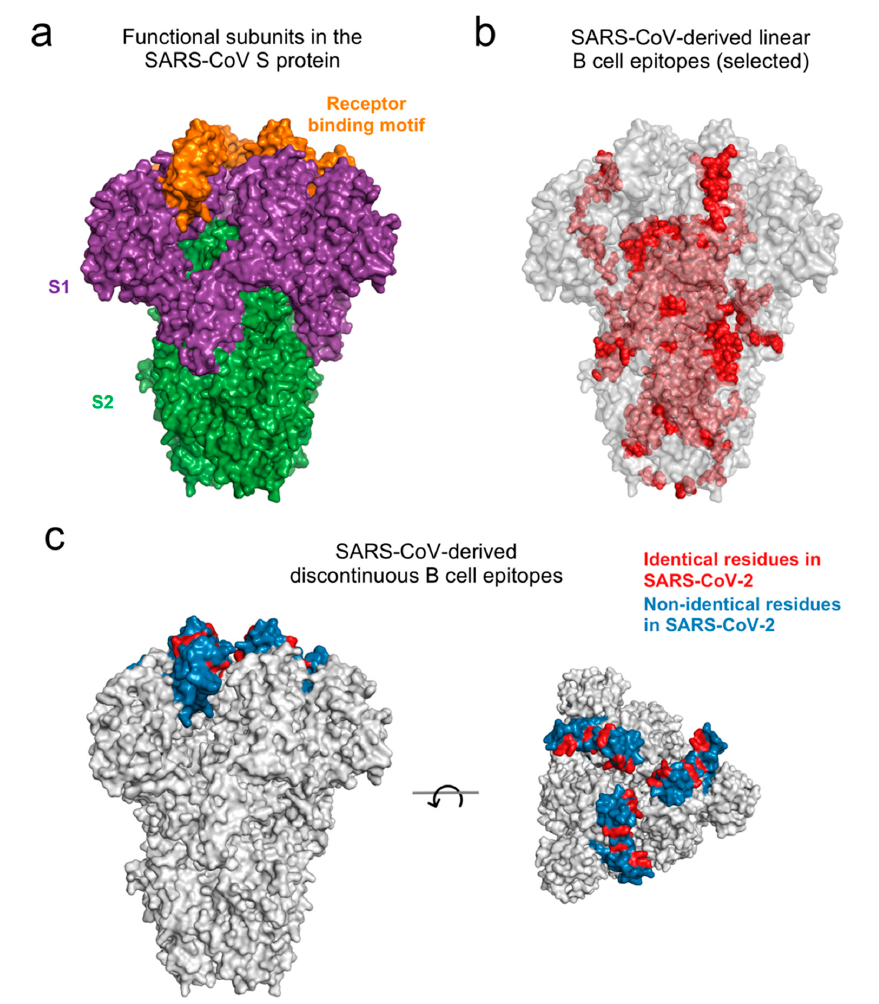
Figure 2. Location of SARS-CoV S protein subunits and SARS-CoV-derived B cell epitopes on the protein structure (PDB ID: 5XLR). ( a ) Subunits S1 and S2 are indicated in purple and green color, respectively. The receptor binding motif lies within the S1 subunit and is indicated in orange color. ( b ) Residues of the linear B cell epitopes, that were identical in SARS-CoV-2 (Table 4), are shown in red color. The dark and light shade reflect the surface and buried residues, respectively. ( c ) Location of discontinuous B cell epitopes that share at least one identical residue with corresponding SARS-CoV-2 sites (Table 5). Identical epitope residues are shown in red color, while the remaining epitope residues are shown in blue color. Both the side view ( left panel ) and the top view ( right panel ) of the structure are shown.